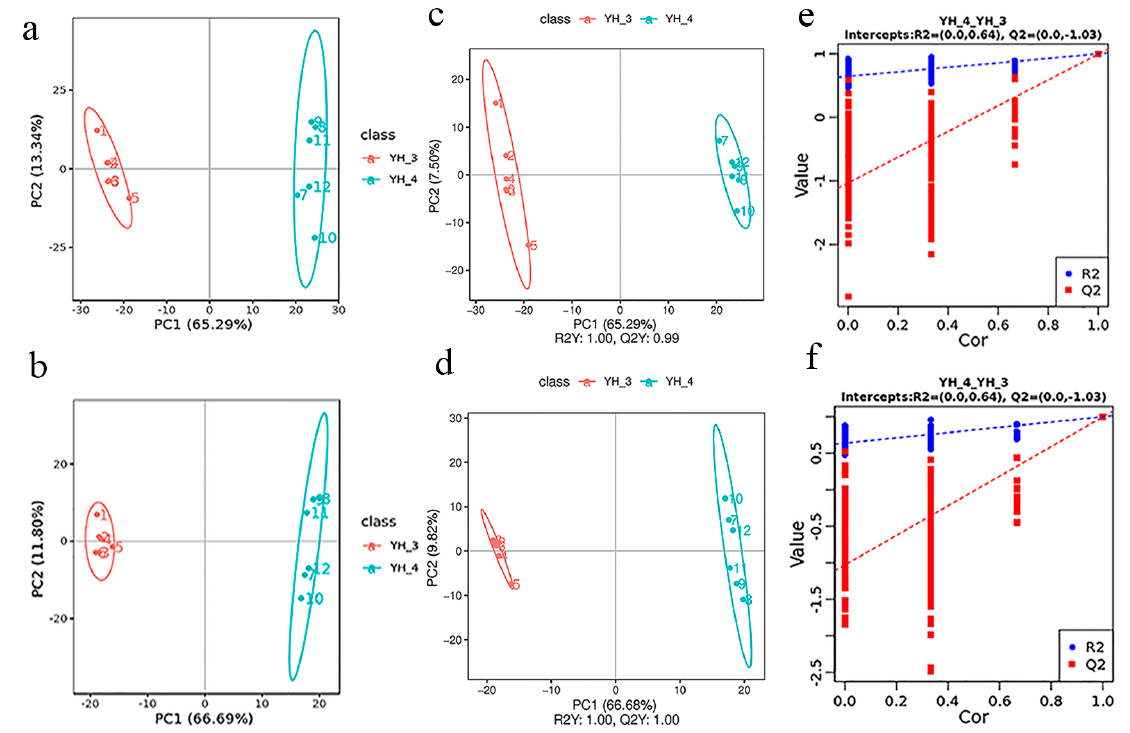
Figure 3. PCA in YH_4 vs. YH_3. ( a ) PCA of the variance-stabilized estimated raw counts of DAMs in positive polarity mode in YH_3 vs. YH_4. ( b ) PCA of the variance-stabilized estimated raw counts of DAMs in negative polarity mode in YH_3 vs. YH_4. ( c ) PLS-DA of DAMs in positive polarity mode in YH_3 vs. YH_4. ( d ) PLS-DA of DAMs in negative polarity mode in YH_3 vs. YH_4. ( e ) Permutation test for positive polarity mode in YH_3 vs. YH_4. ( f ) Permutation test for negative polarity mode in YH_3 vs. YH_4.